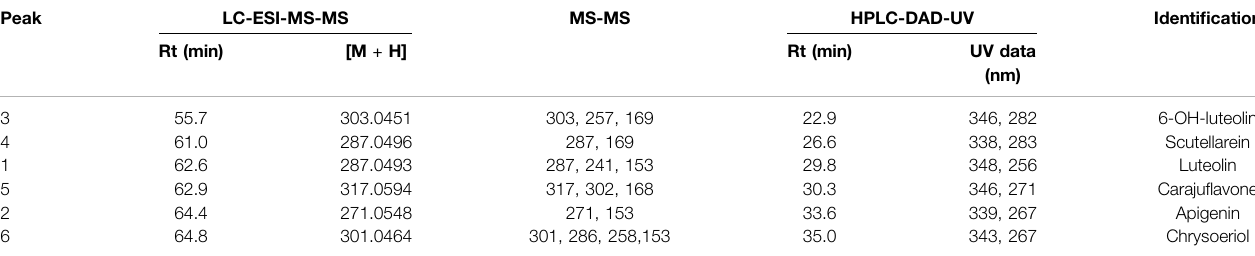
TABLE 1 | LC-ESI-MS-MS and HPLC-DAD-UV data of fl avone-rich fraction obtained from Arrabidaea chica Verlot. Peak